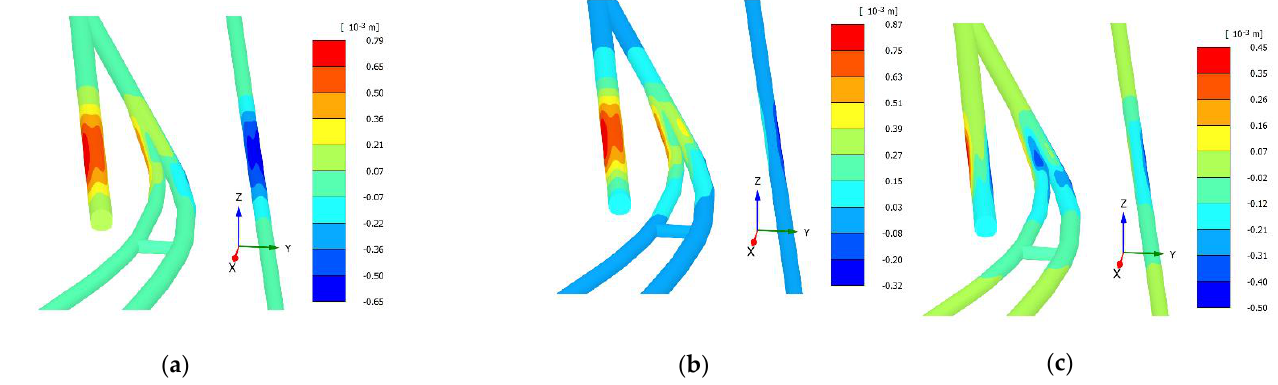
14 of 19 ( c ) Figure 10. Numerical results and field data of horizontal displacement of the tunnel: ( a ) stage 3, ( b ) stage 4, ( c ) stage 5. 4.3. Horizontal Convergence of the Tunnel Figure 11 demonstrates the simulated nephogram of the horizontal displacement of